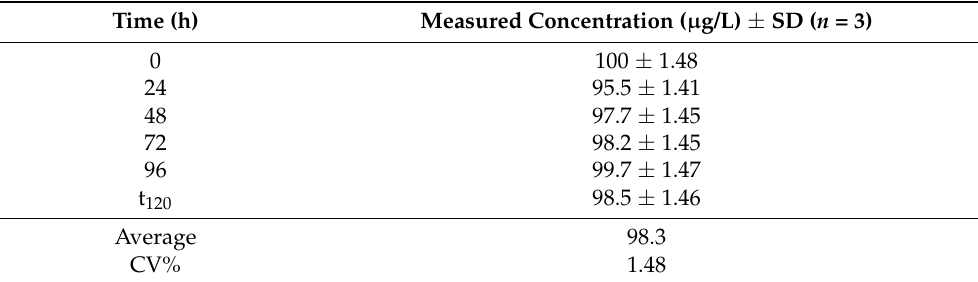
Table 1. Actual concentrations measured in the dilution water without fish after spiking with a nominal concentration of 100 µ g/L